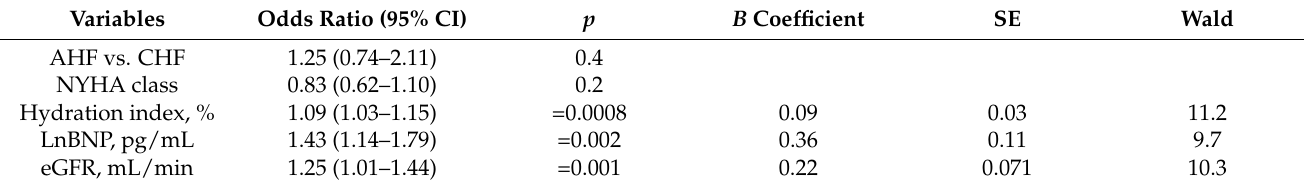
Table 2. Predictors of anemic status in logistic multivariate regression analysis.